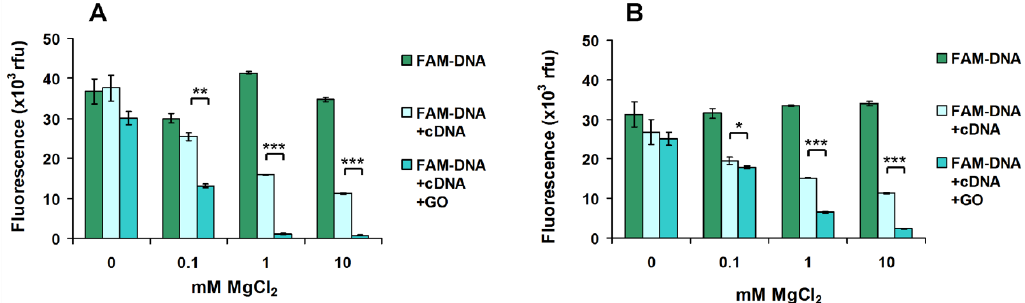
Figure 4. In the presence of MgCl 2 , Tween-20 did not alter FAM – DNA/cDNA hybridization, but reduced subsequent GO interaction. ( A ) The effect of increasing MgCl 2 concentration on FAM – DNA/cDNA hybridization and subsequent interaction with GO. ( B ) The effect of 0.01% Tween-20 on the experimental conditions of ( A ). For ( A ) and ( B ), 25 nM L − 1 FAM – DNA/cDNA hybridization for 60 min at room